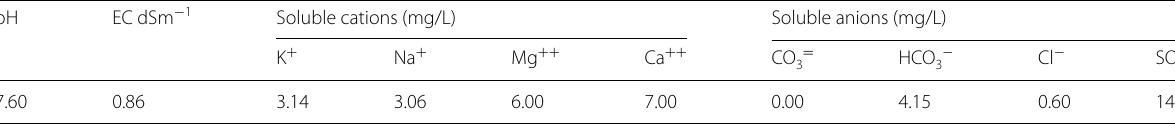
Table 2 Chemical analysis of irrigation water. (Average of two years) pH EC dSm − 1 Soluble cations (mg/L) Soluble anions